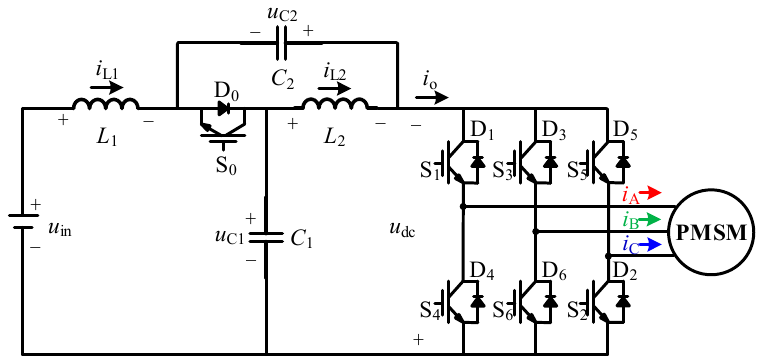
Figure 3. Equivalent circuit of the PMSM system driven by qZSI.